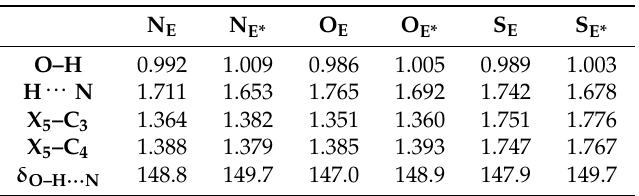
Table 2. Bond length (Å) and angle formed by O-H ··· N ( δ O–H ··· N , o ) for enolic form of N E , S E , and O E in ground state (S 0 = E ) and first excited singlet state (S 1 = E* ).